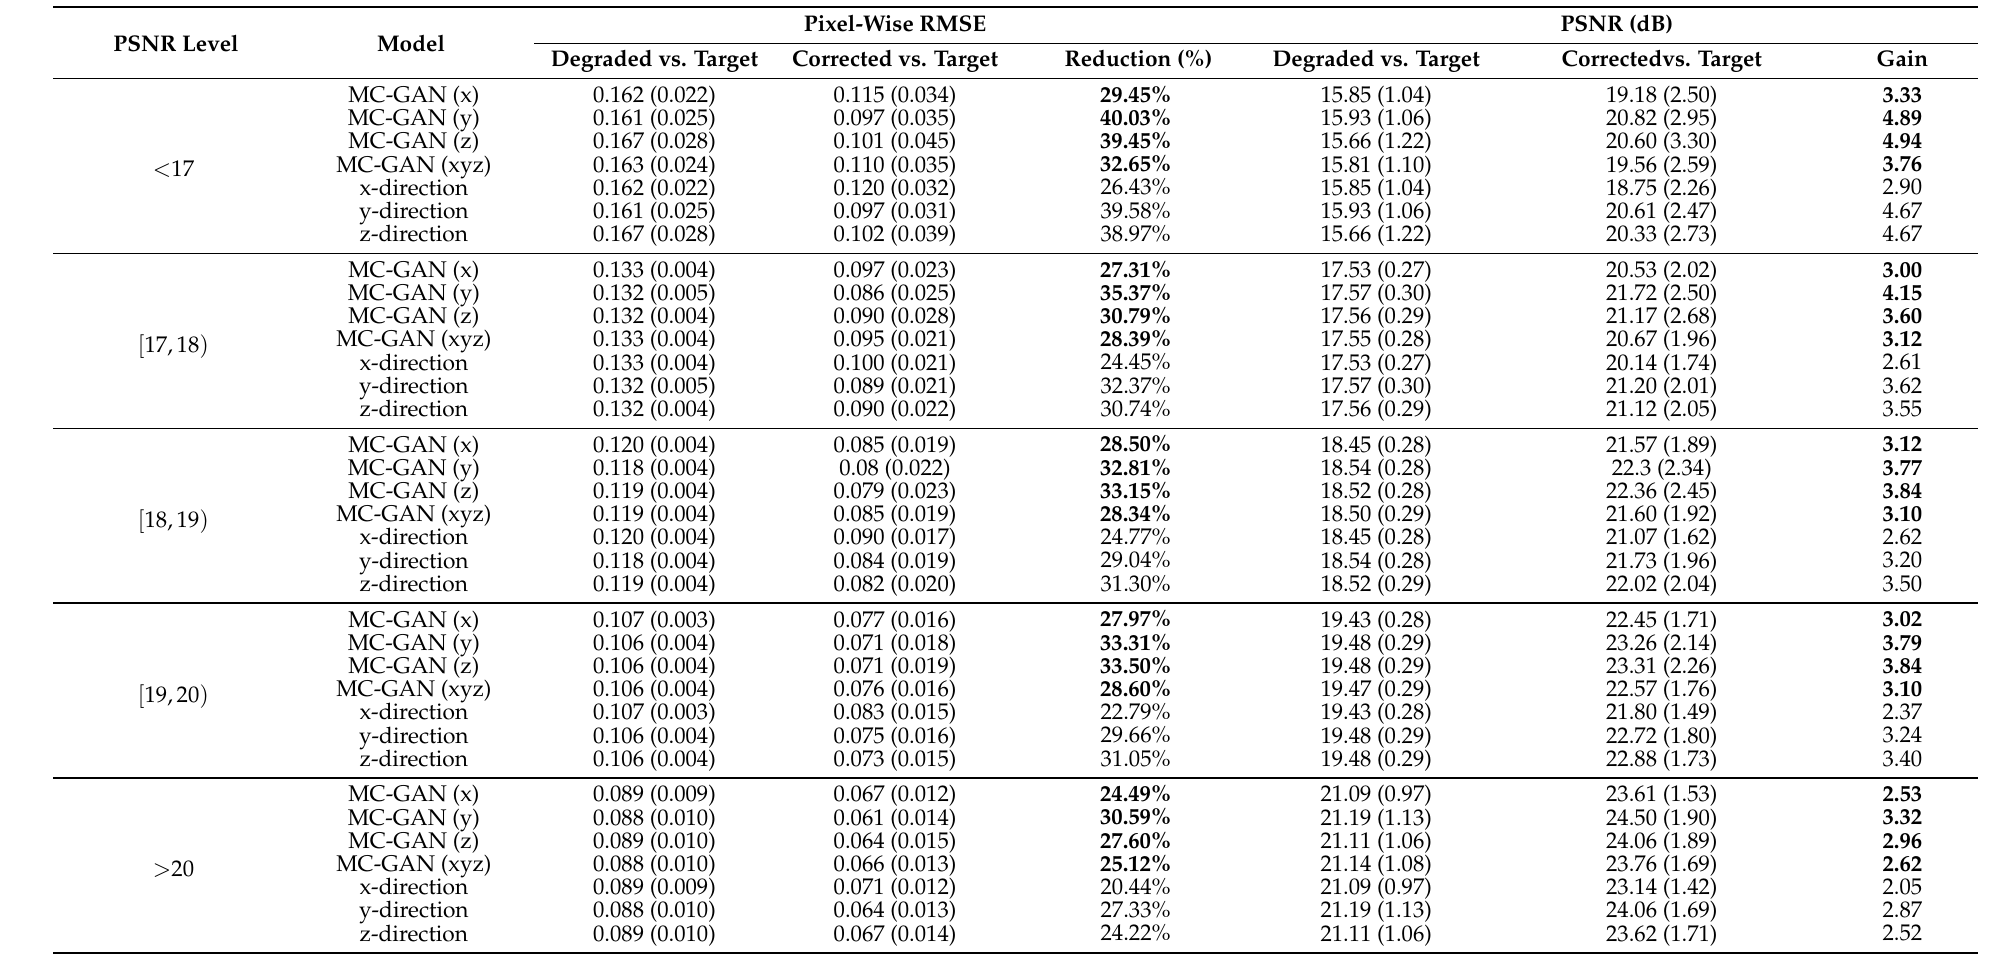
Table 1. Quantitative Evaluation on Synthetic Data Across Different Degradation Levels.